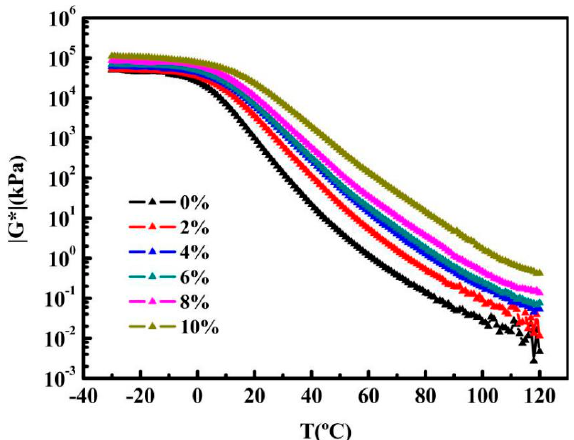
Figure 5. Temperature sweeps results of control asphalt and GMAs (complex modulus versus temperature) at − 30–120 °C (PP25). temperature) at − 30–120 ◦ C